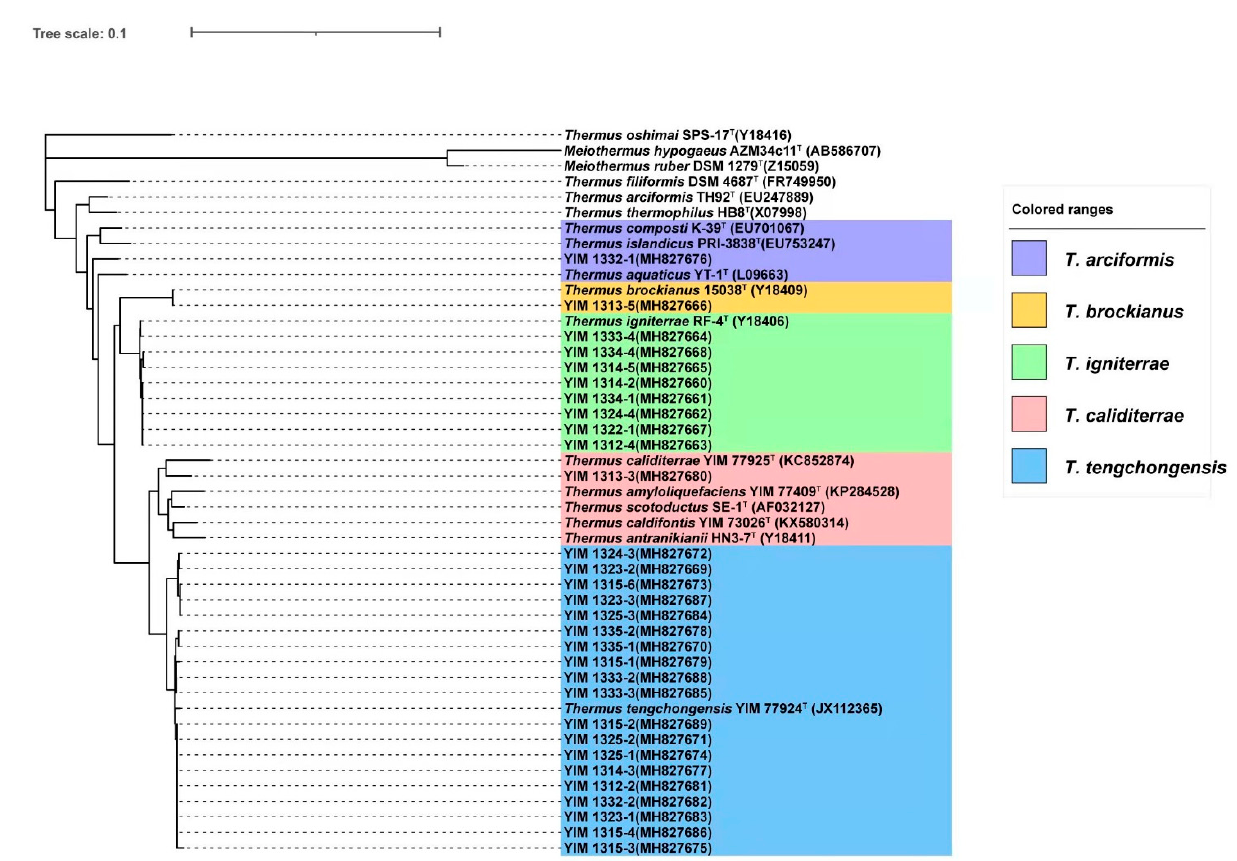
Figure 5. The phylogenetic tree for the culturable Thermus strains in the Dehong geothermal region. Numbers at nodes indicate bootstrap values (>50%) based on a neighbor-joining analysis of 1000 resampled datasets. The vertical scale bar in the middle represents 0.1 substitutions per nucleotide position.